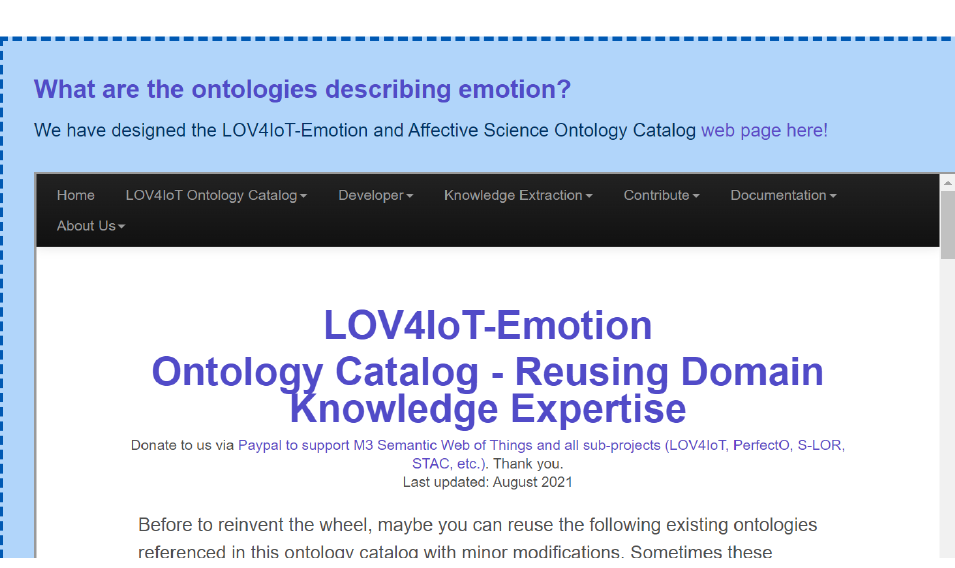
Figure A1. What are the basic emotions according to Ekman et al. [81]?